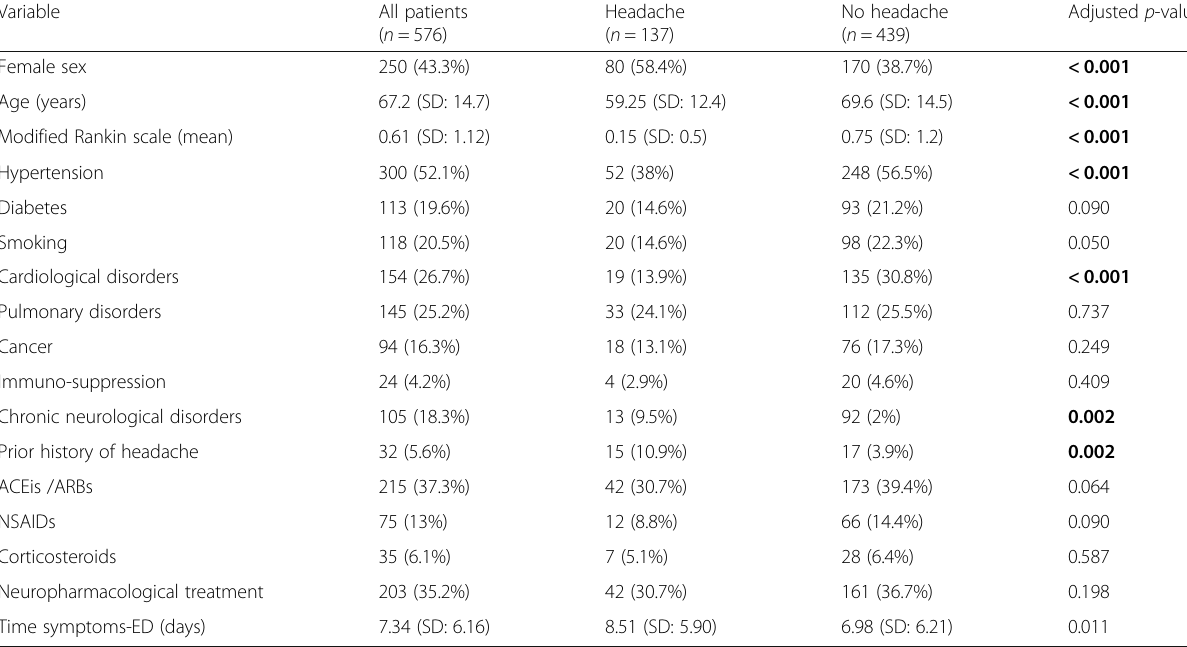
Table 1 Frequency of baseline variables the entire sample and comparison between patients with and without headache Variable All patients ( n =